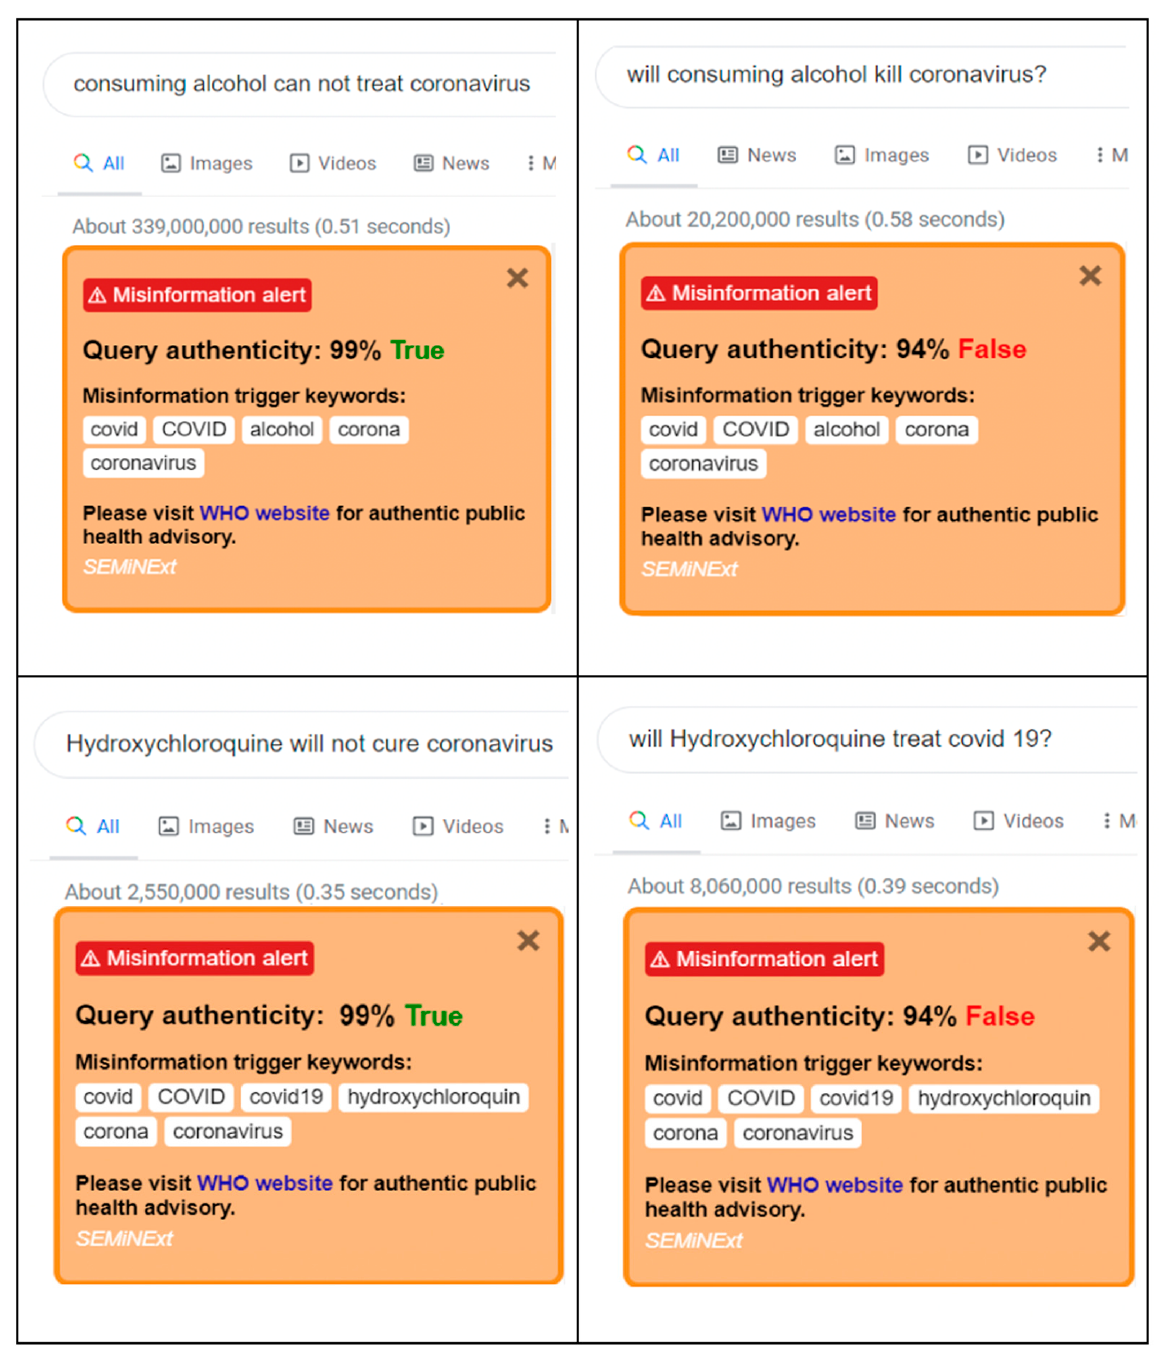
Figure 5. In this portion, the overall performances between the statistical methods and ANN is shown.